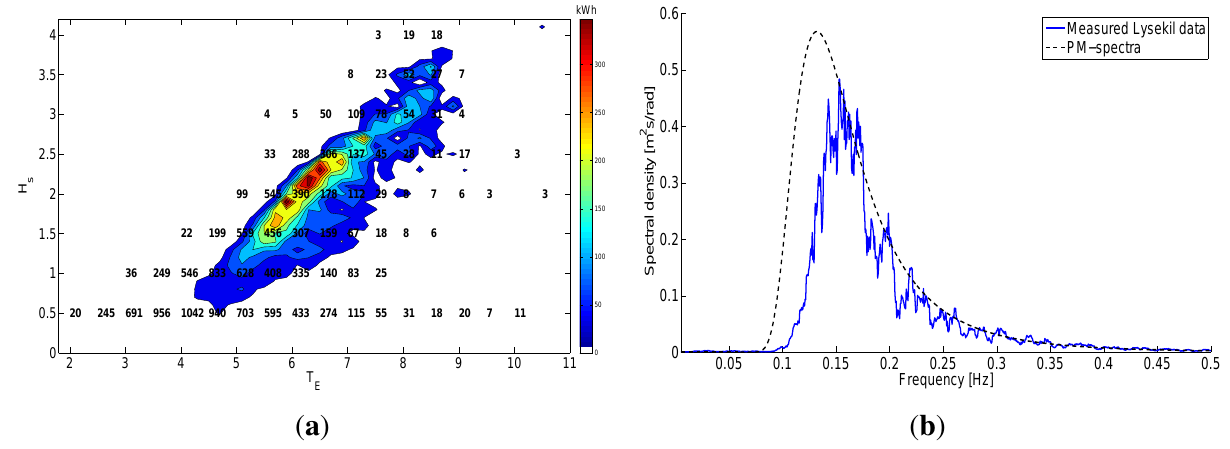
Figure 5. Wave data at the